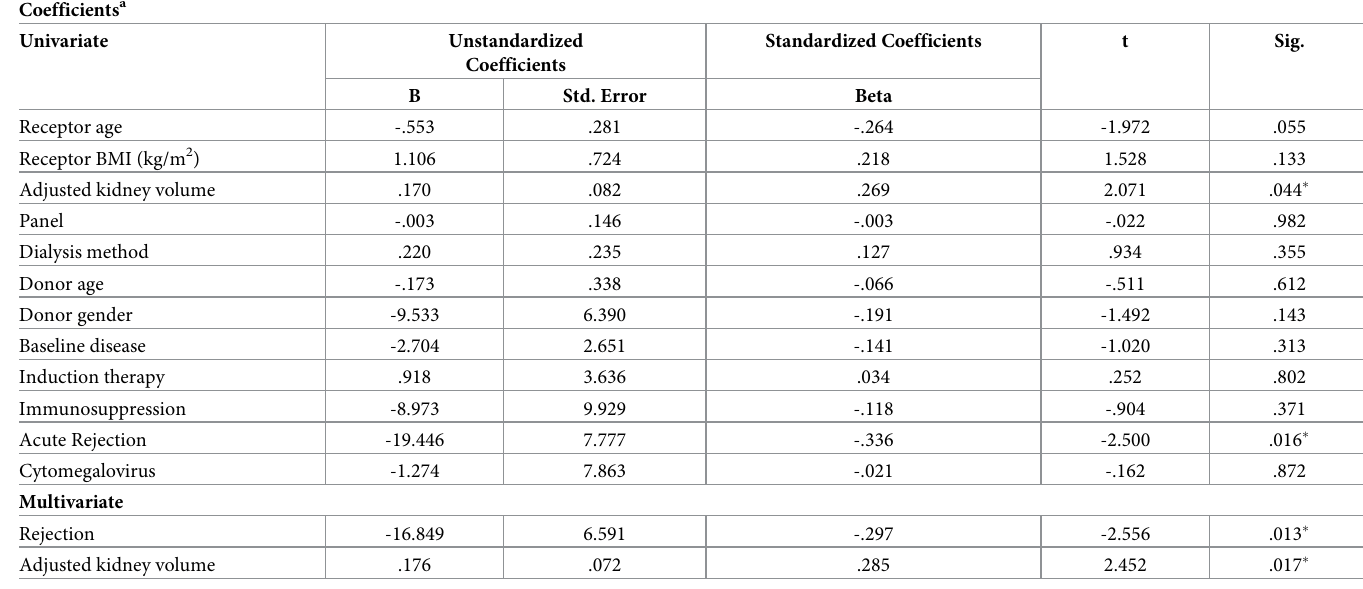
Table 2. Linear regression univariate and multivariate analysis–factors associated with improved kidney function after one year–living donor